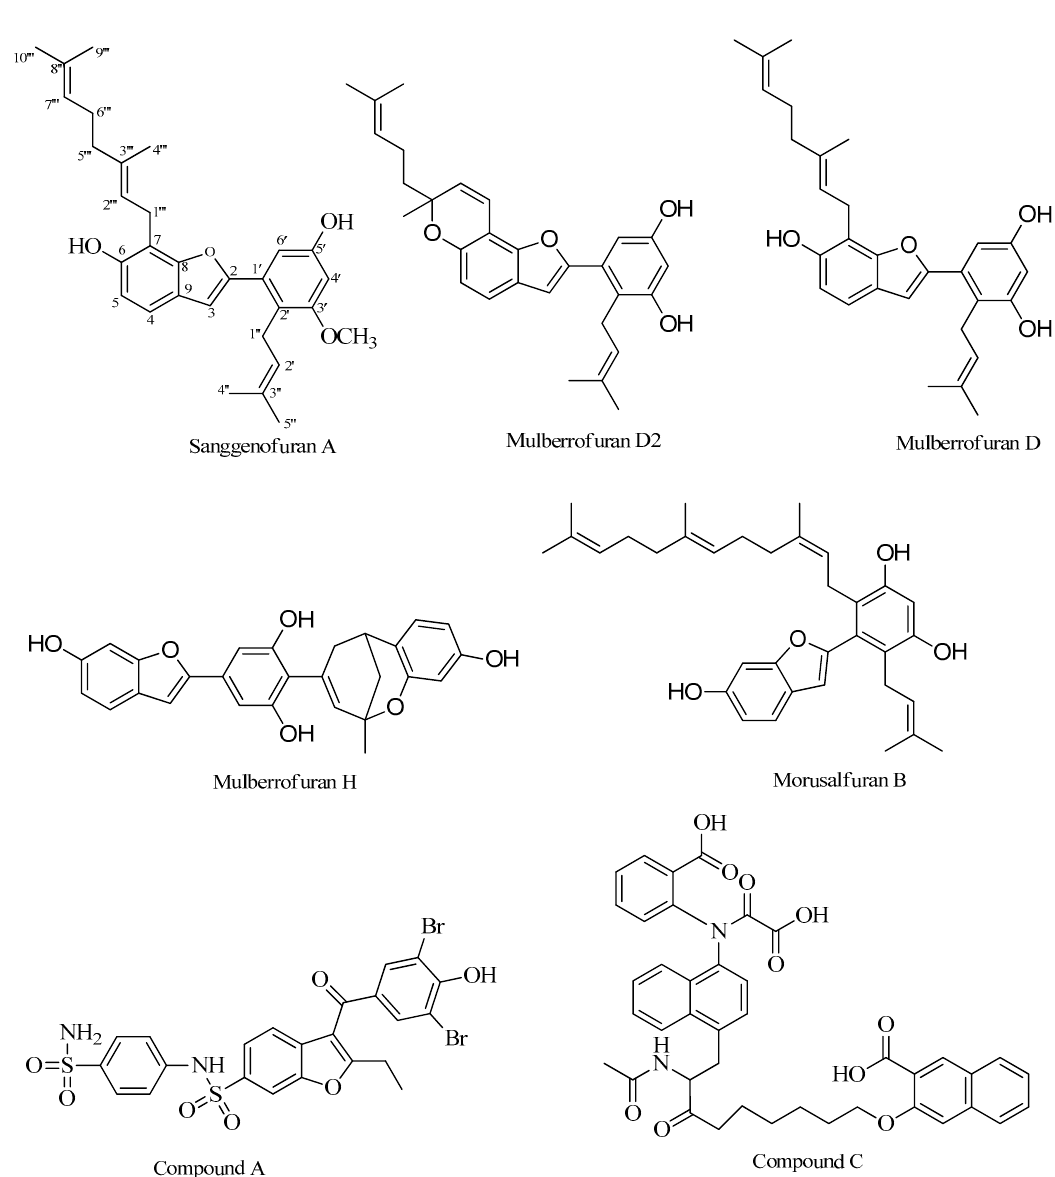
Figure 1. Structures of five 2-arylbenzofurans, one allosteric inhibitor (compound A ), and one catalytic inhibitor (compound C ) selected for our study.